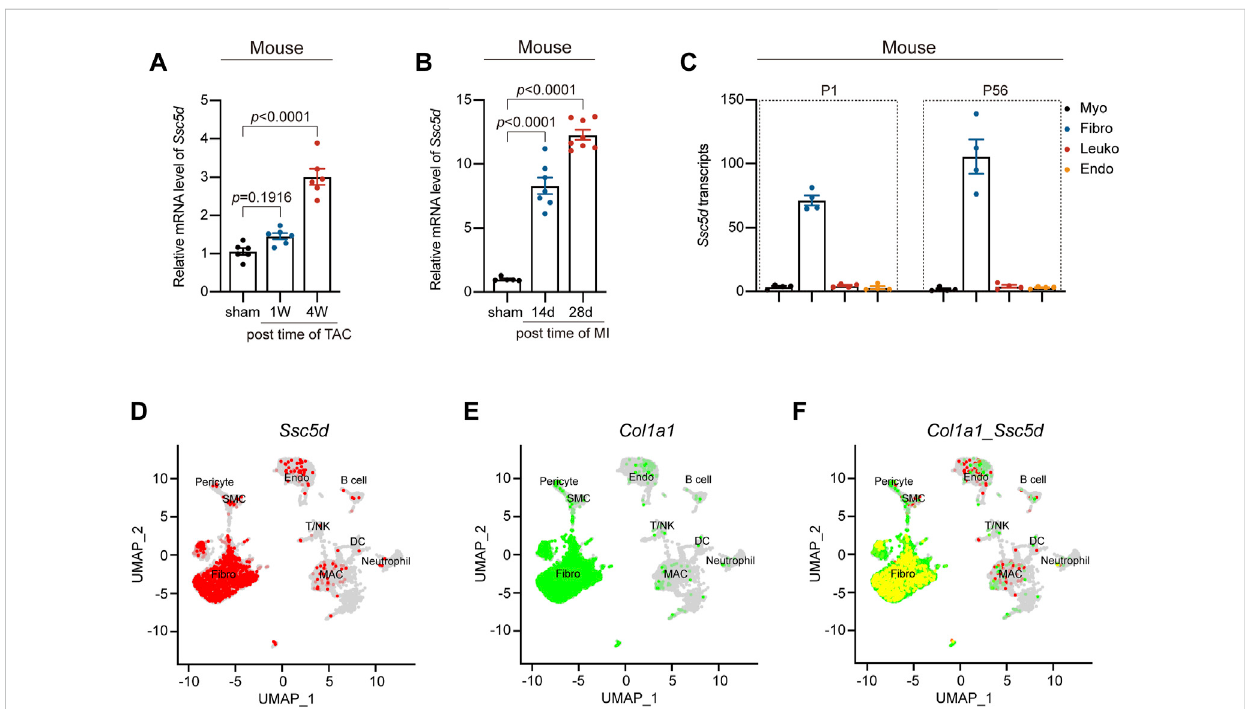
FIGURE 2 Ssc5d mRNA levels were signi fi cantly elevated inMI and TACmouse models. (A,B) The relativemRNA expressionof Ssc5d after TAC(1and 4 W) (n = 6) and MI (14 and 28 days) (n = 5 – 7) surgery. (C) Normalized Ssc5d expression (CPM) in each cell type at neonatal (P1) or adult stages (P56) mouse hearts (GSE95755). Myo (black), cardiomyocytes; Fibro (blue), fi broblasts; Leuko (red), leukocytes; Endo (orange), endothelial cells. (D – F) UMAP plot of Ssc5d and Col1a1 co-expression in sham mice cardiac non-cardiomyocyte clusters. Red, Ssc5d ; Green, Col1a1 ; Yellow, Ssc5d and Col1a1 co-expression. Fibro, fi broblasts;SMC,smoothmusclecell;MAC,macrophage;DC,dendriticcell;Endo,endothelial;CPM,countspermillion;W,week;d,day. p -value < 0.05 was considered statistically signi fi